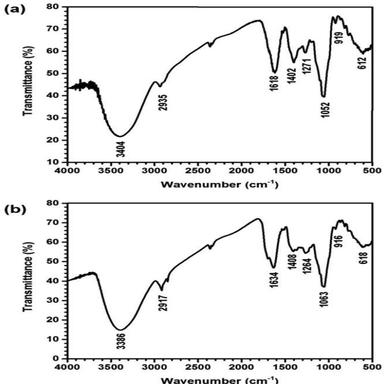
FTIR spectra of (a) Lonicera japonica flower extract and (b) synthesized AuNPs.